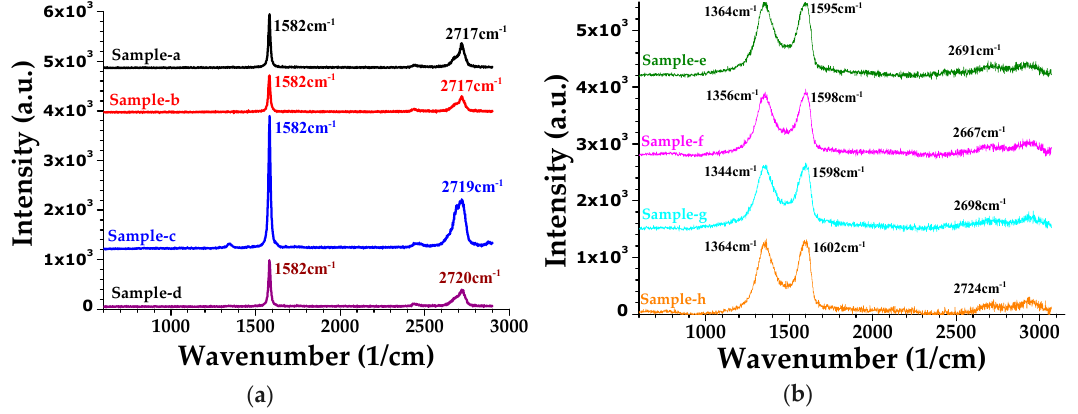
Figure 3. Raman peaks of: ( a ) GML (samples a–d), and ( b ) GOL (samples e–h); λ exc = 532 nm.